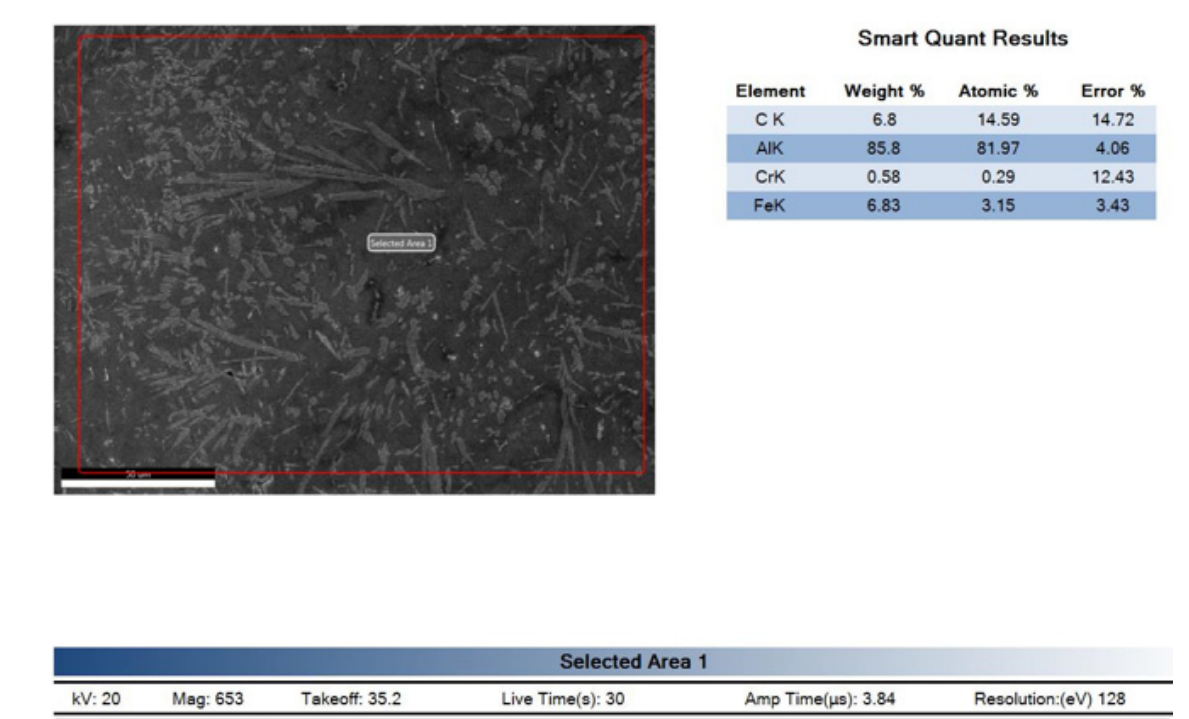
Figure 8. EDX of the stirrer material.